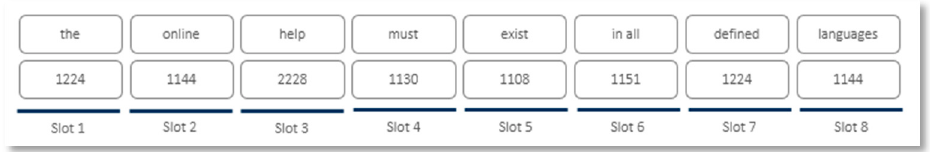
Figure 3. View of a Requirement after KM indexer